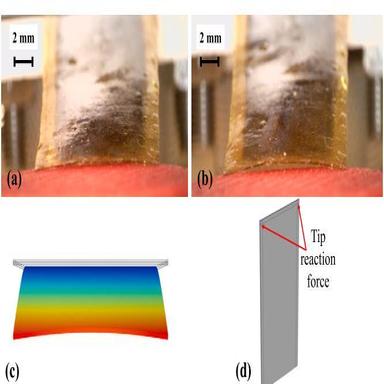
(a) Actuator tip with no applied electric field. (b) Actuator tip when an electric field of 20 ∕ is applied. (c) Simulated tip deflection for longitudinally aligned nanofibers. (d) Evaluation of the tip reaction force for actuators with fiber longitudinally aligned.